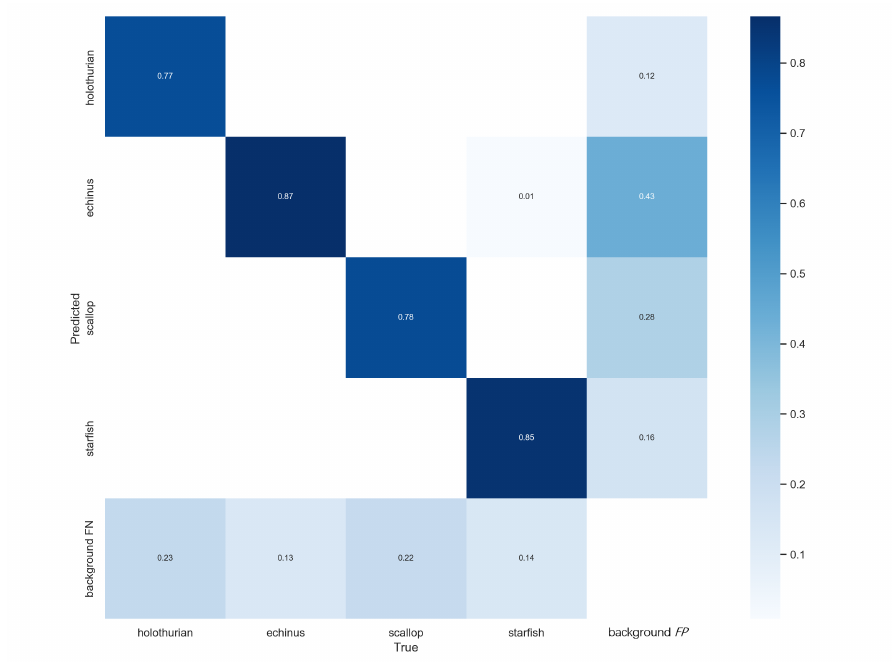
Figure 11. The confusion matrix of the improved YOLOv5s.